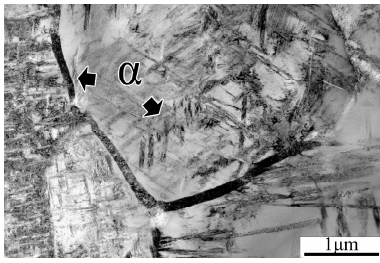
Figure 2. Transmission electron microscope (TEM) image of the alloy after thermomechanical processing.